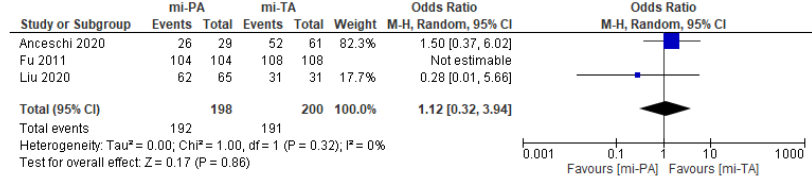
postoperative improved hypertension, and ( k ) postoperative plasma renin activity. IV = inverse